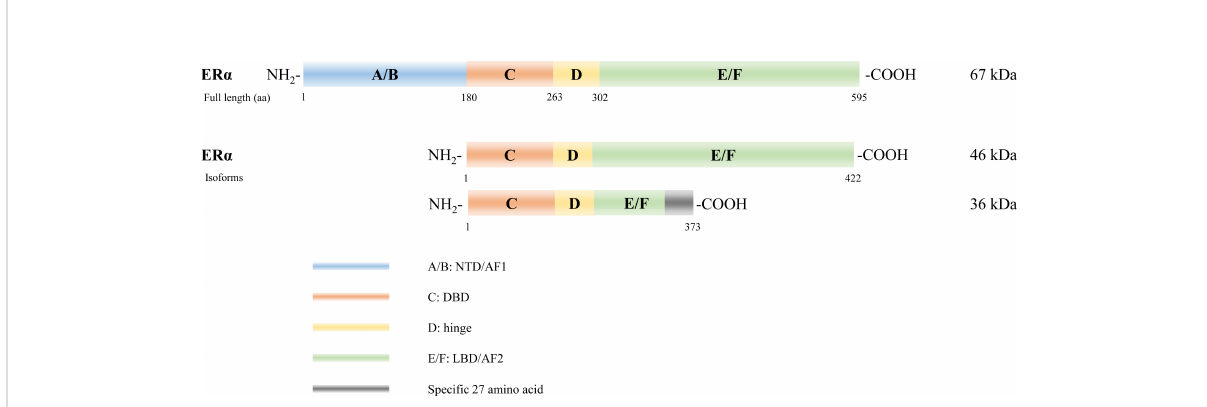
FIGURE 2 Estrogen receptor alpha (ER a ) isoforms. Six structural and functional domains are highlighted: A, B domain (amino- or NH 2 -terminal domain [NTD], AF1), C domain (DNA binding domain [DBD]), D domain (hinge region connecting the C and E domain), E, F domain (carboxyl- or COOH-terminal, ligand-binding domain [LBD], AF2).